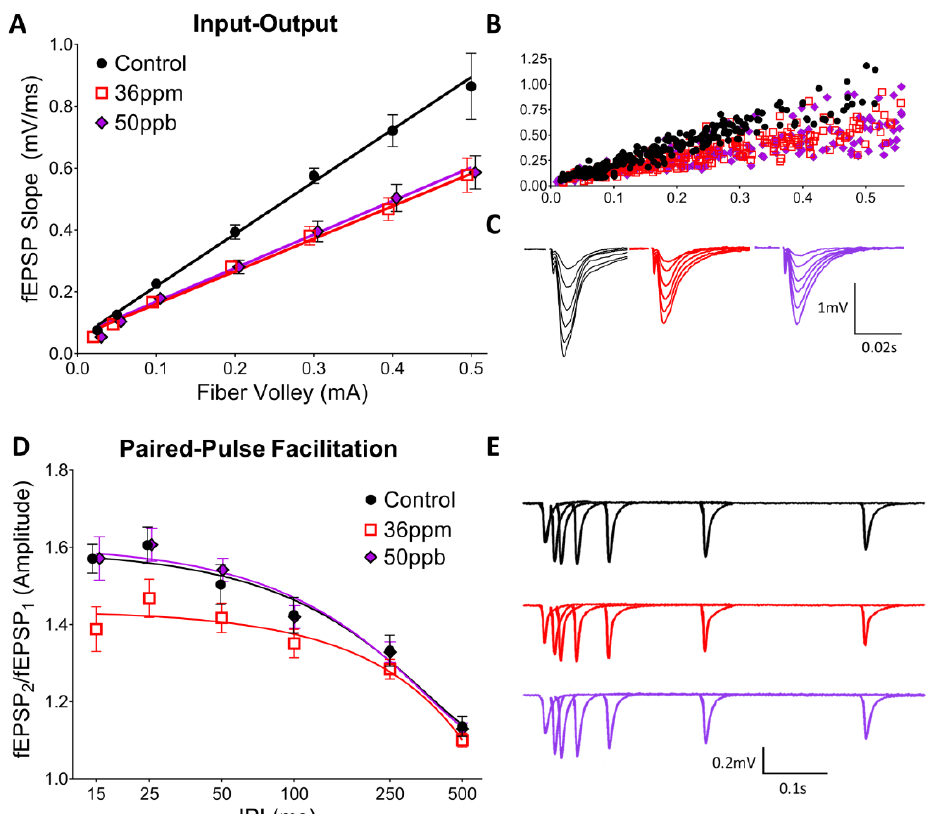
Figure 1. Effect of arsenic on hippocampal basal synaptic transmission ( A – C ) and short-term presynaptic plasticity ( D , E ), as assessed using input–output curves and paired-pulse facilitation, respectively. ( A ) Averaged responses for input-output experiments, ( B ) pre-binned, raw values from all experiments, and ( C ) waveforms averaged by fiber volley bin from representative experiments. ( D ) Averaged responses for paired-pulse facilitation experiments and ( E ) waveforms averaged by inter-pulse interval from representative experiments.